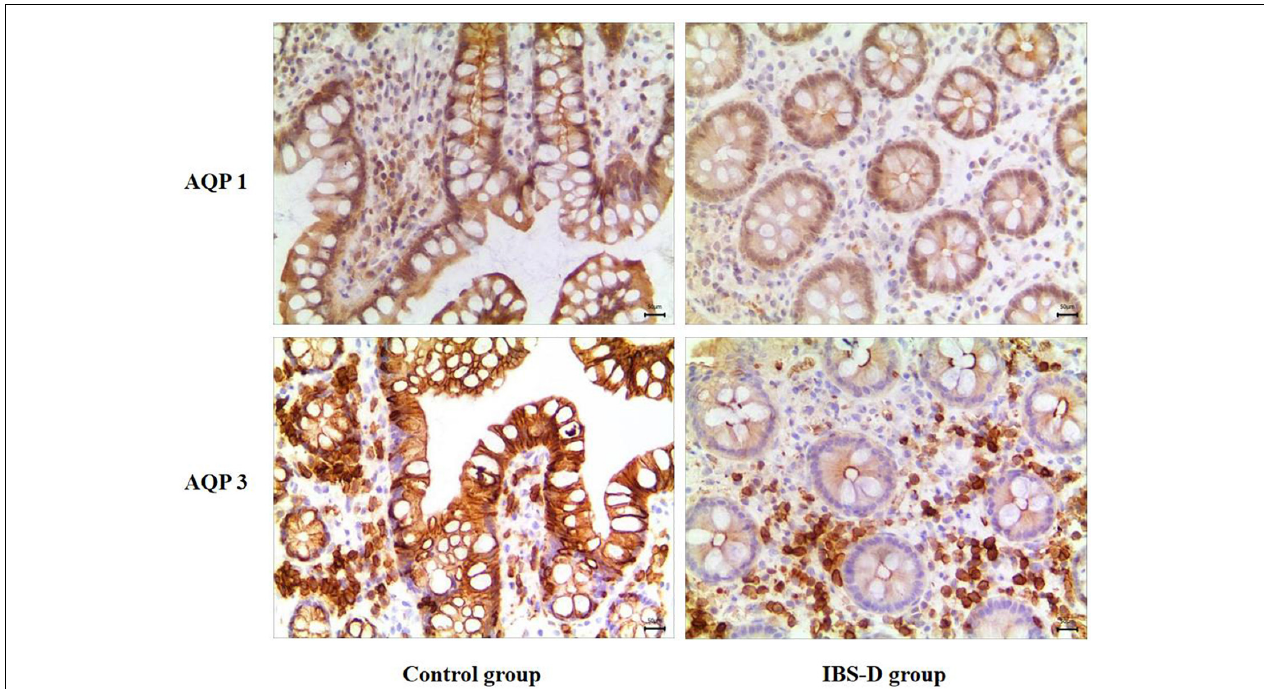
FIGURE 1 | Immunohistochemical results of AQP1 and AQP3 in the two groups of subjects ( × 200). As shown in the picture, the brown or yellow positive stained particles mainly localized in the cytoplasm of the cells, rather than in the nuclei. Distributed in the cell membrane of intestinal mucosa cells, the amount of AQP1, 3 in patients with IBS-D was less than that in the control group.